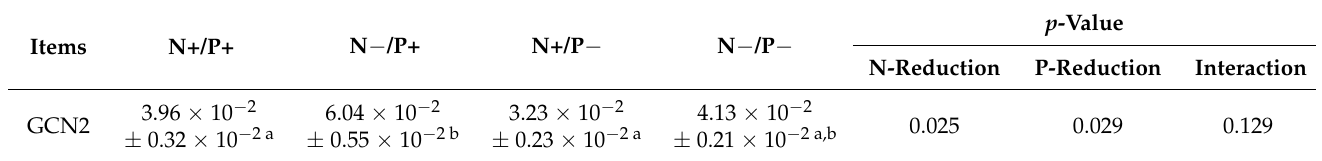
Table 7. Relative amount of GCN2 protein expression in the liver of young goats fed an N- and/or P-reduced diet.